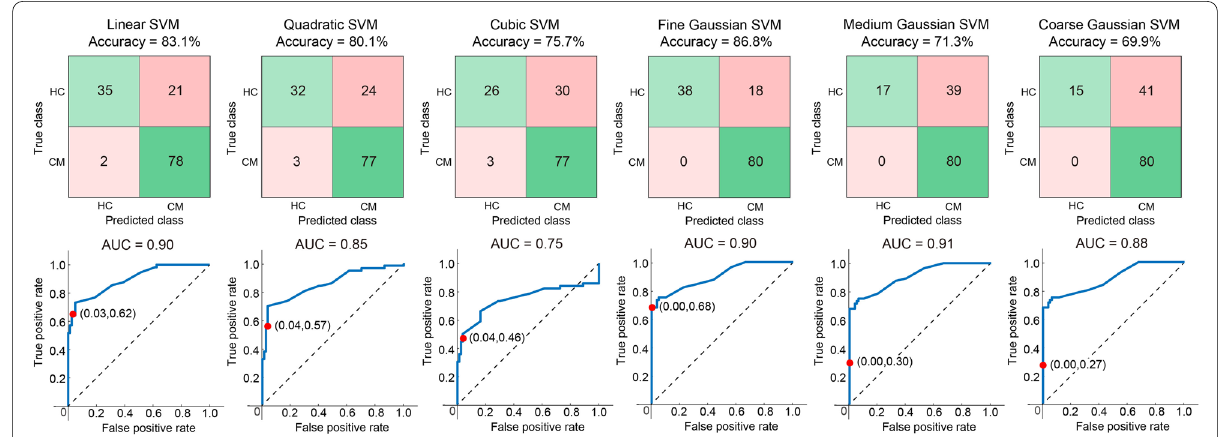
Fig. 3 Accuracy and area under the curve (AUC) of machine learning analysis with six kernels for classifying chronic migraine (CM) from healthy controls (HCs) in the training data set. SVM, support vector